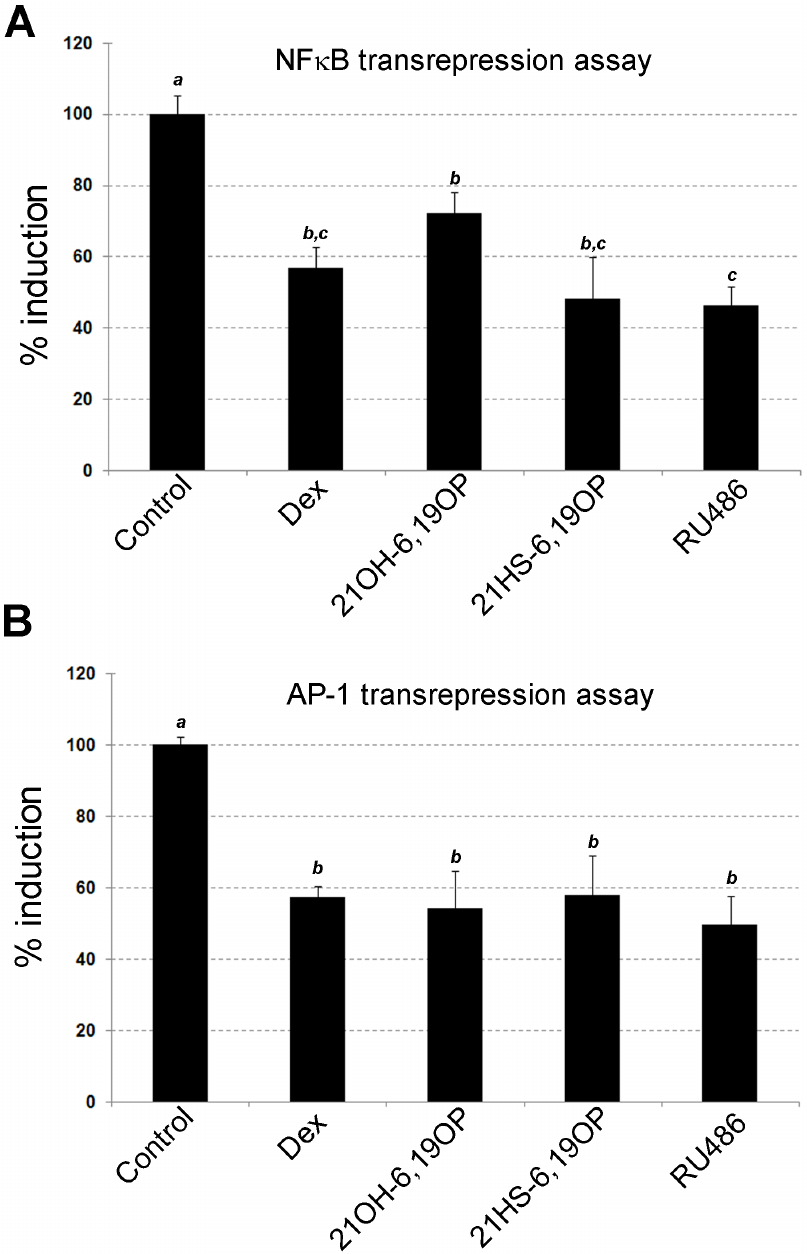
Figure2.GR-ligandcomplexesmonomericactivity. BHK21cellswerecotransfectedwithpkB-LUCandpRelAvectors( A ),orpAP1-LUCandpcJunvectors ( B ). pCMV-LacZ vector were also introduced. Cells were incubated for 18 h with ethanol (Control), 10 nM Dex, 10 m M 21OH-6,19OP, 10 m M